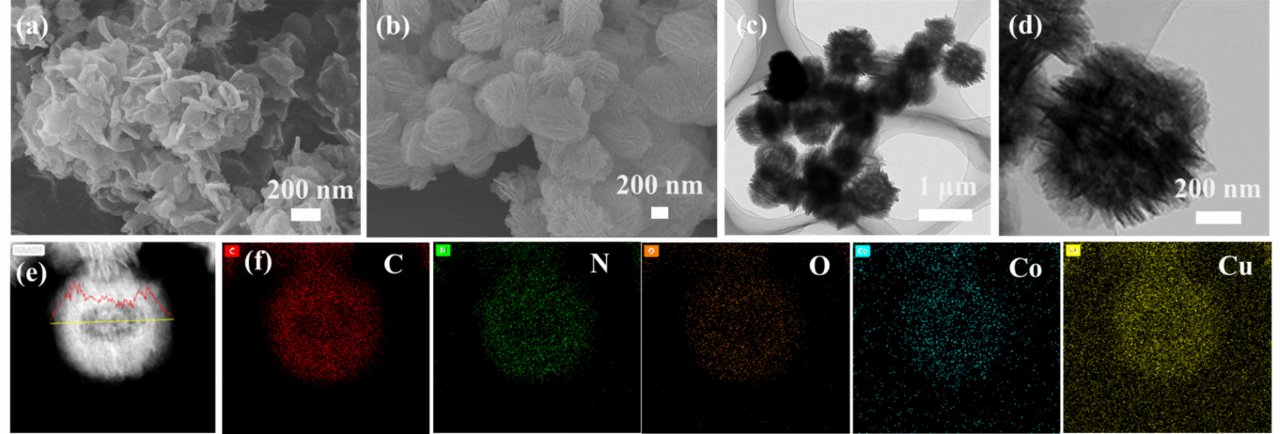
Figure 1. ( a ) SEM image of Co-pPD; ( b ) SEM image of CoCu-pPD; ( c , d ) TEM images of CoCu-pPD; ( e ) High-angle annular dark-field scanning transmission electron microscopy (HAADF-STEM) image of CoCu-pPD; ( f ) The corresponding elemental mapping of C, N, O, Co, and Cu elements on the CoCu-pPD.